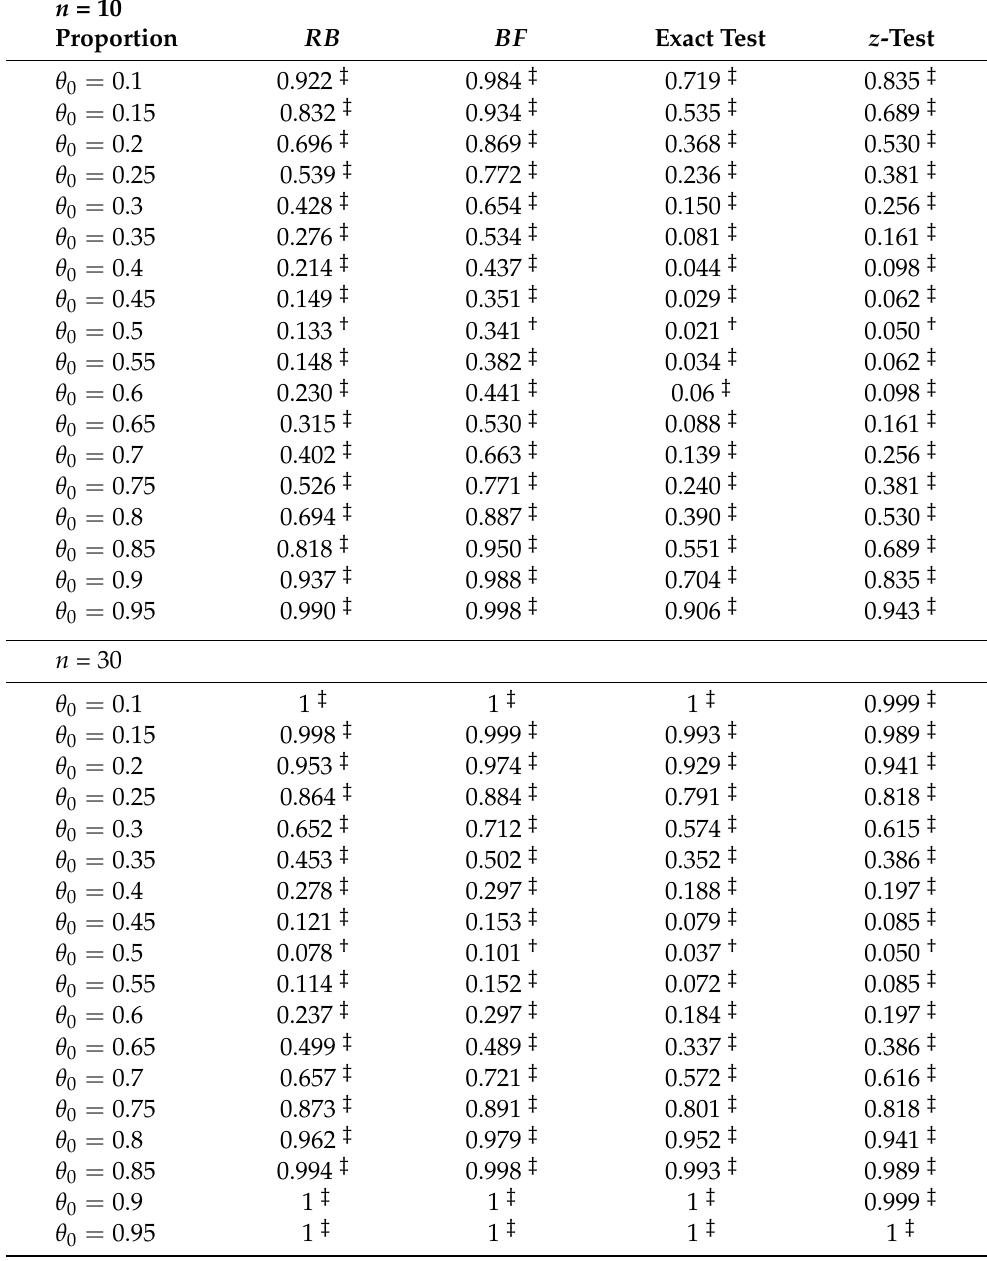
Table 3. The proportion of rejecting H 0 out of 1000 replications based on samples of size n = 10 and n = 30 is reported. Here, † represents the ratio of false positives for the tests and ‡ represents the ratio of the true